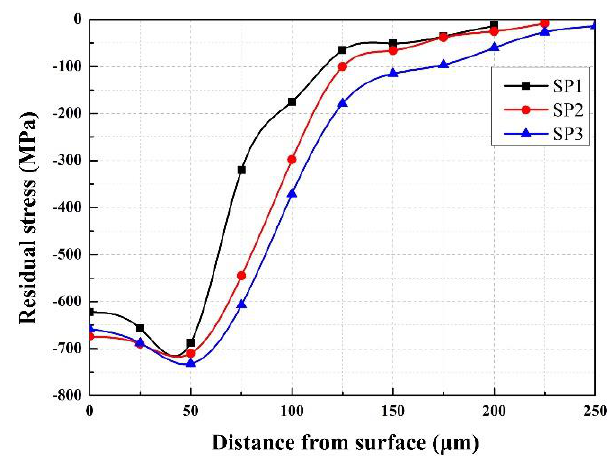
Figure 10. Residual stress distribution of the shot-peening specimens.